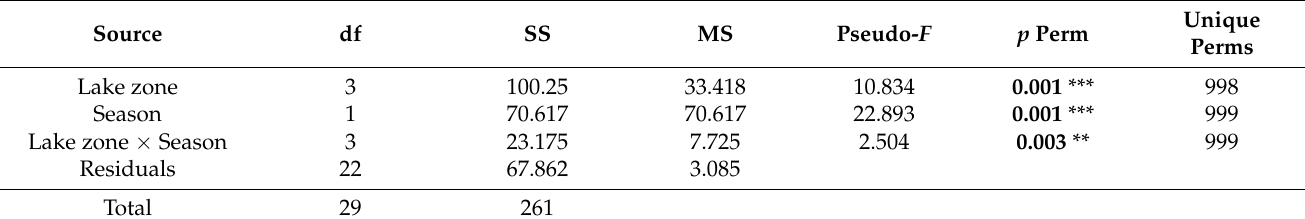
Table 3. Table of the principal results of permutational multivariate analysis of variance (PER- MANOVA) test. The total variation is partitioned according to four sources: lake zone, season, lake zone × season—interaction between lake zone and season factors, residuals. Bold values indicate significant results (** p ≤ 0.01, *** p ≤